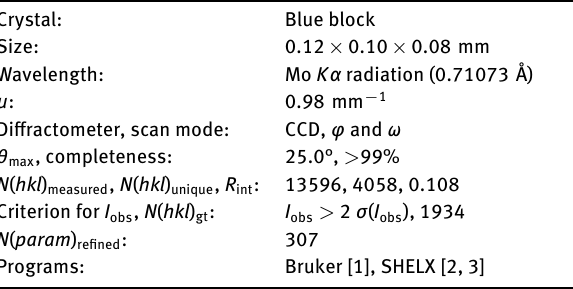
Table 1: Data collection and